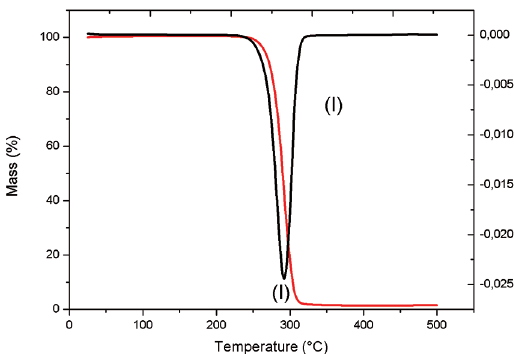
Figure 7: TGA and DTG curves of PHB before processing. Heating rate: 10 °C.min -1 under nitrogen atmosphere flow of 50 mL.min -1